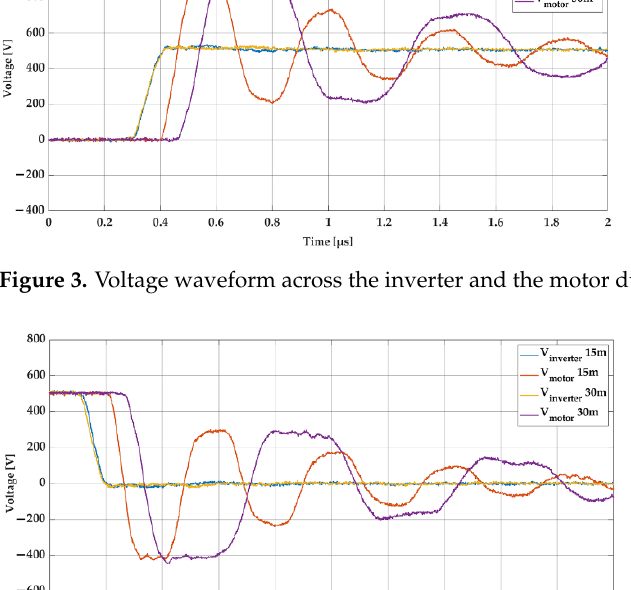
Figure 5. Electrical circuit of snubber two-level (S2L) inverter: (1) DC-bus capacitor in orange, (2) recovery circuit in green, (3) three-phase inverter circuit in blue, and (4) snubber circuit in pink.